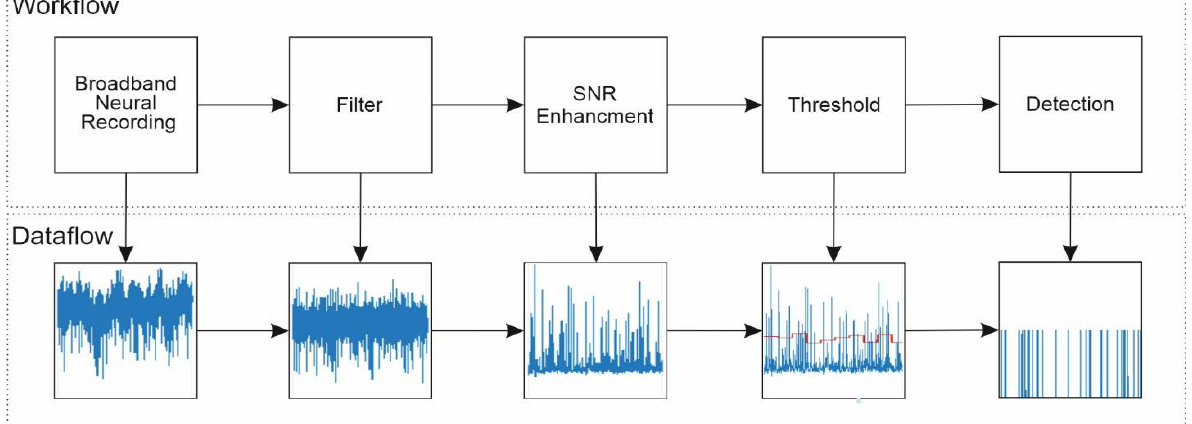
Figure 2. The workflow summarizes the followed processing steps of the proposed method while the dataflow shows the effect of each block on the input signal coming from the recording matrix up to detection. It worth noticing that the threshold is evaluated by the smoothed signal as variance. Then a constant factor is used to adjust the detection rate.